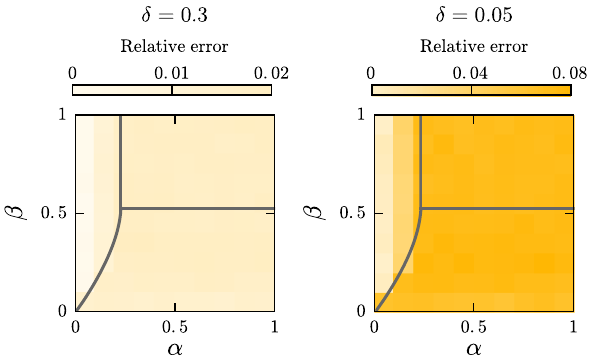
FIG. 16. Comparison of the density profiles of all lanes for a system with W ¼ 5 lanes. The density profiles are identical for each lane and for both species. No symmetry breaking takes place. Inorder to improvevisibility,onlyevery100thlattice site is plotted for every lane, with a different offset for each lane. Other